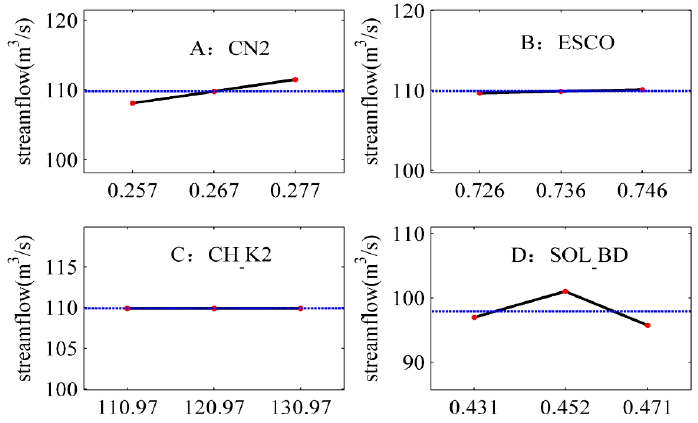
Figure 8. Individual effects of parameters in the pre-flood period.